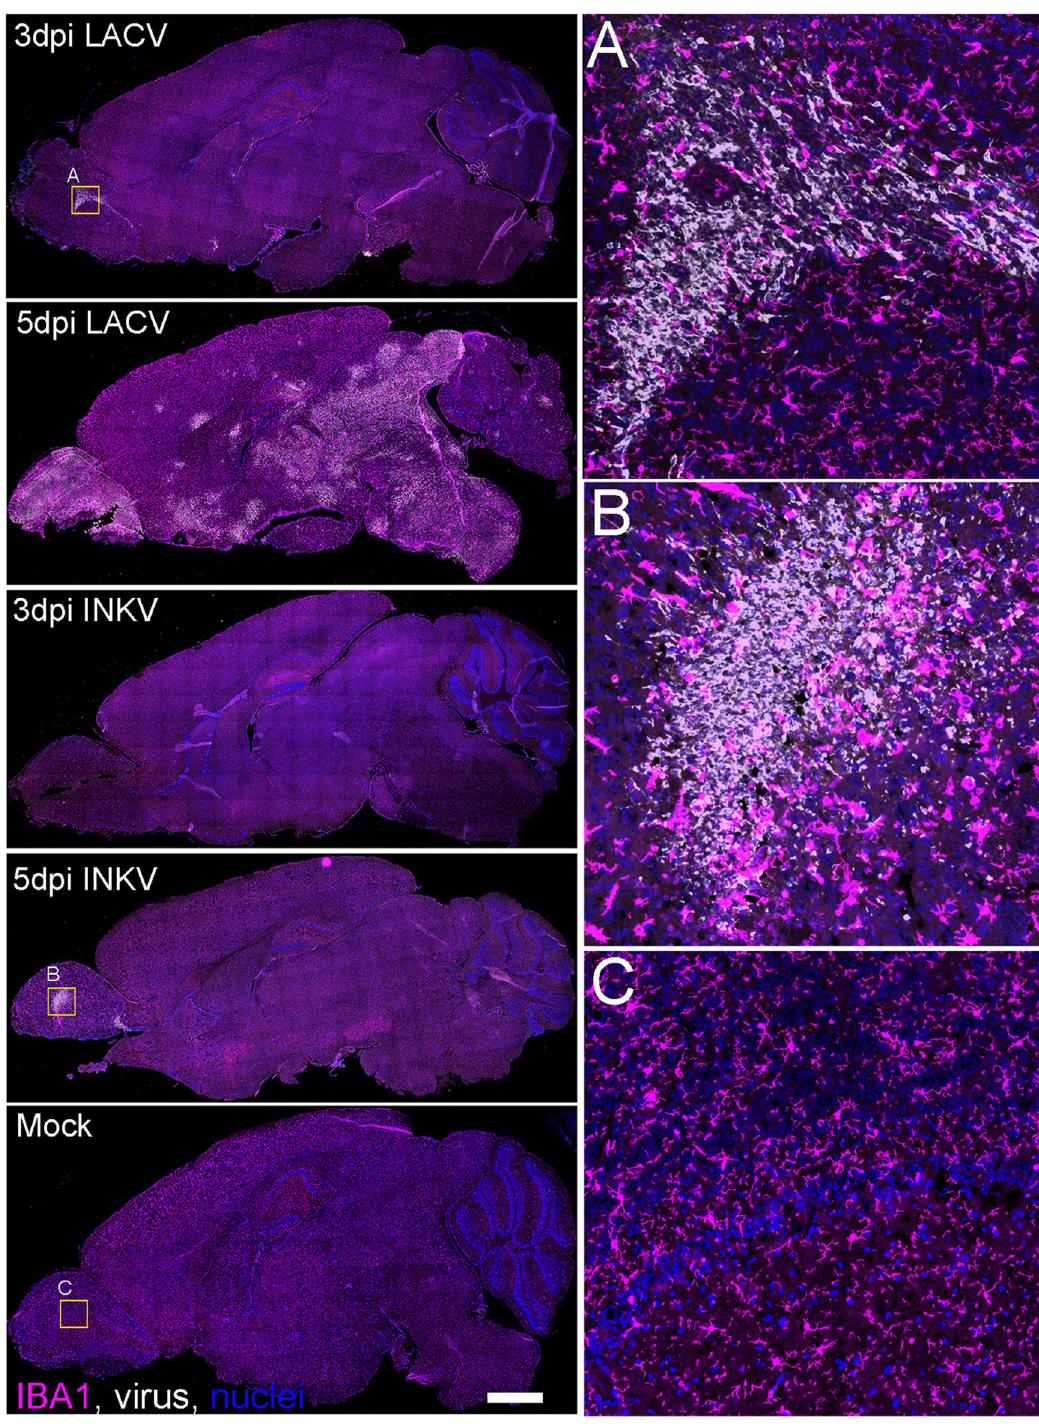
Fig 5. Immune responses to LACV and INKV infection in the brain. Representative whole-brain sagittal sections from (left column, top to bottom), 3 dpi LACV, 5 dpi LACV, 3 dpi INKV, 5 dpi INKV and mock-inoculated mice were immunohistochemically labeled for the myeloid/microglia-specific marker ionized calcium binding adaptor molecule 1 (IBA1, magenta), virus (white) and cell nuclei (blue). The white scale bar in the mock-inoculated panel represents 1mm and corresponds to all other images. The yellow boxes in the 3 dpi LACV (A), 5 dpi INKV (B), and mock-inoculated (C) sections correspond to high magnification insets shown in the right column highlighting the myeloid cellular morphology in the olfactory bulb of each respective